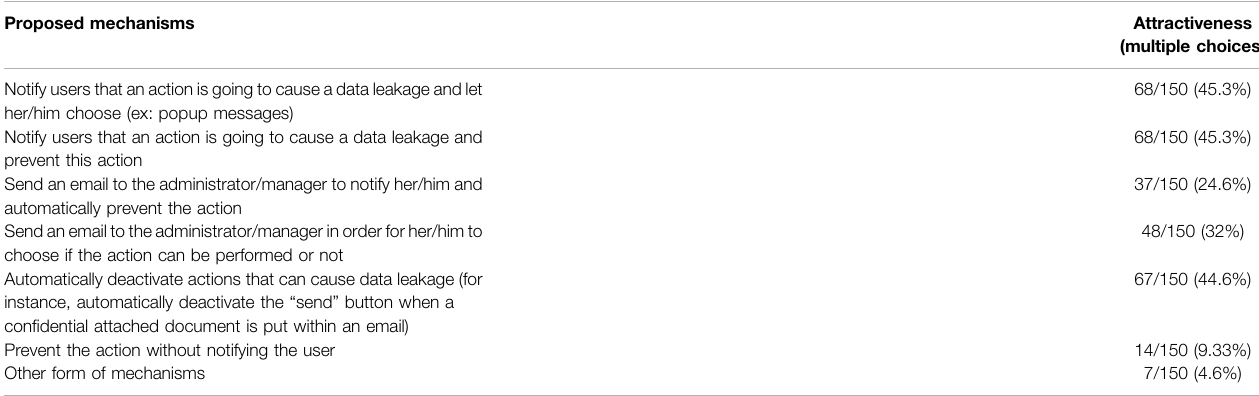
TABLE 10 | Proposed mechanisms and their